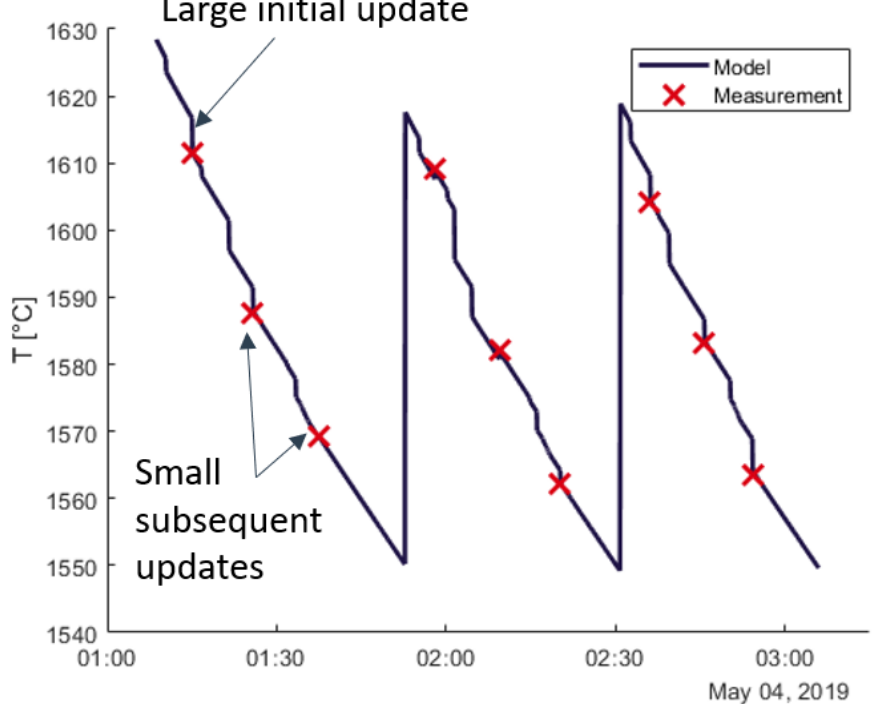
Figure 4. Temperature evolution and estimation improvement during the course of the